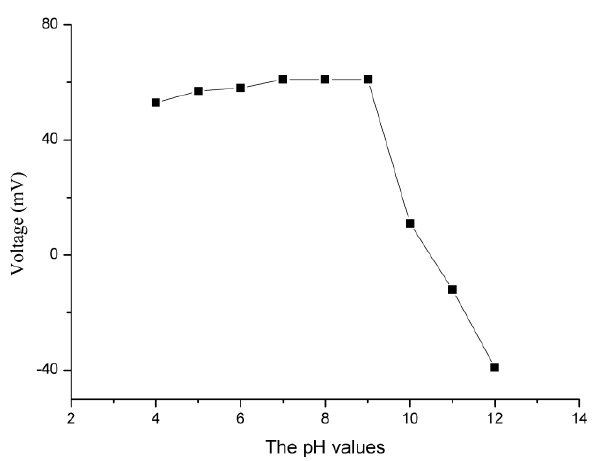
Figure 3. Calibration curves showing the study of EMF response with the variation of pH